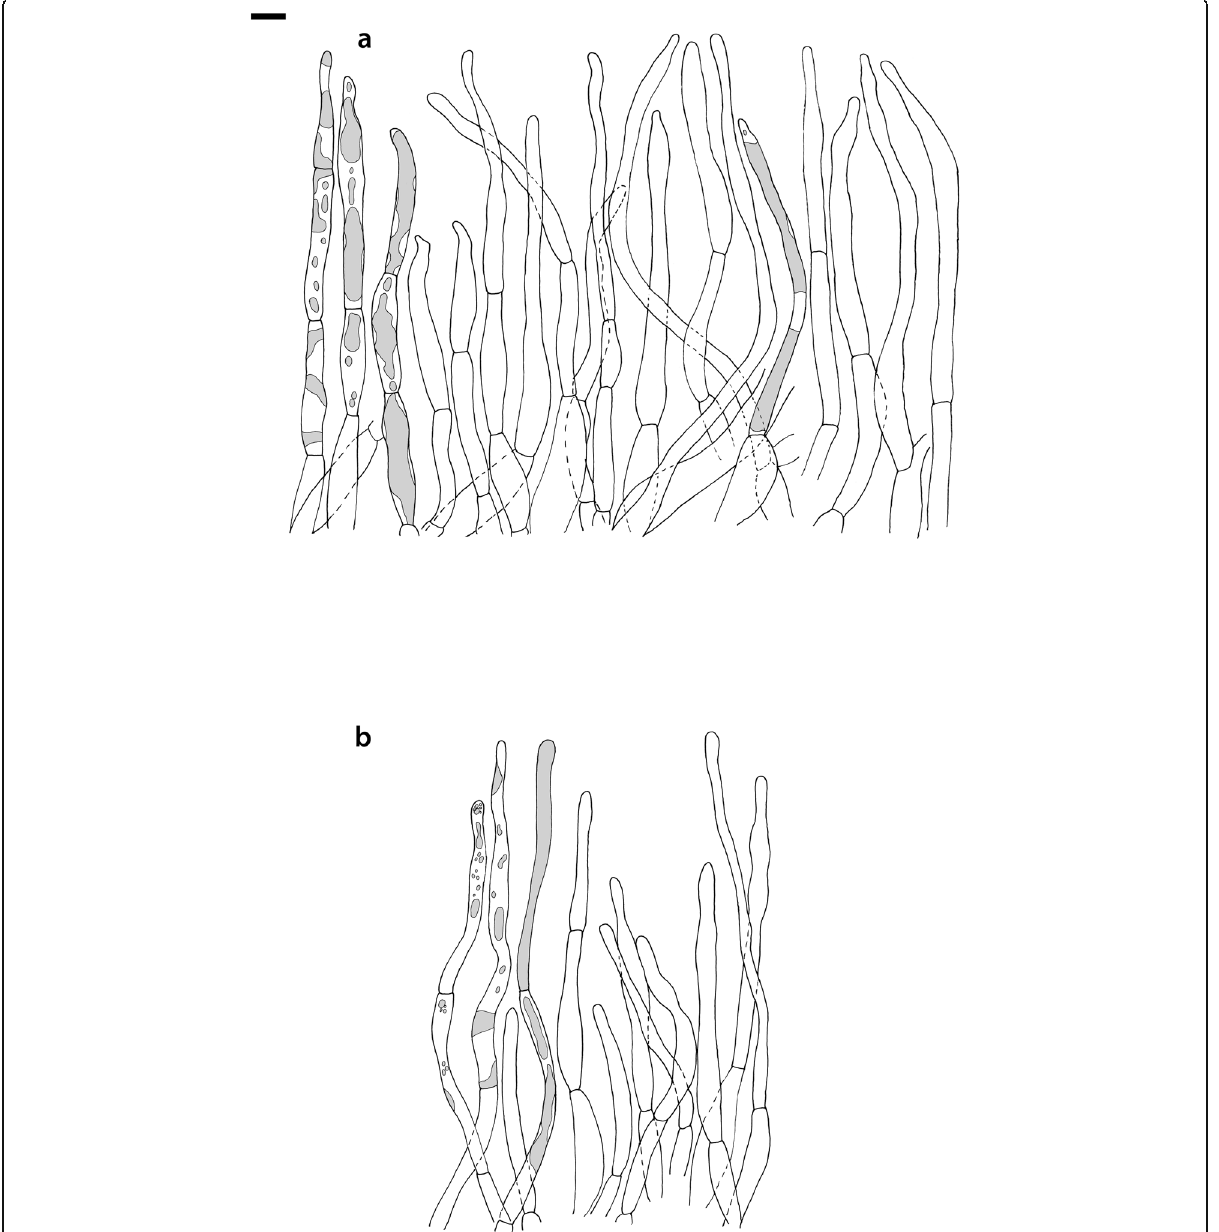
Fig. 5 Russula albonigra (SAF F-755, SAV F-20177), hyphal terminations of the pileipellis. a Near the pileus margin. b Near the pileus centre. Bar=10 μ